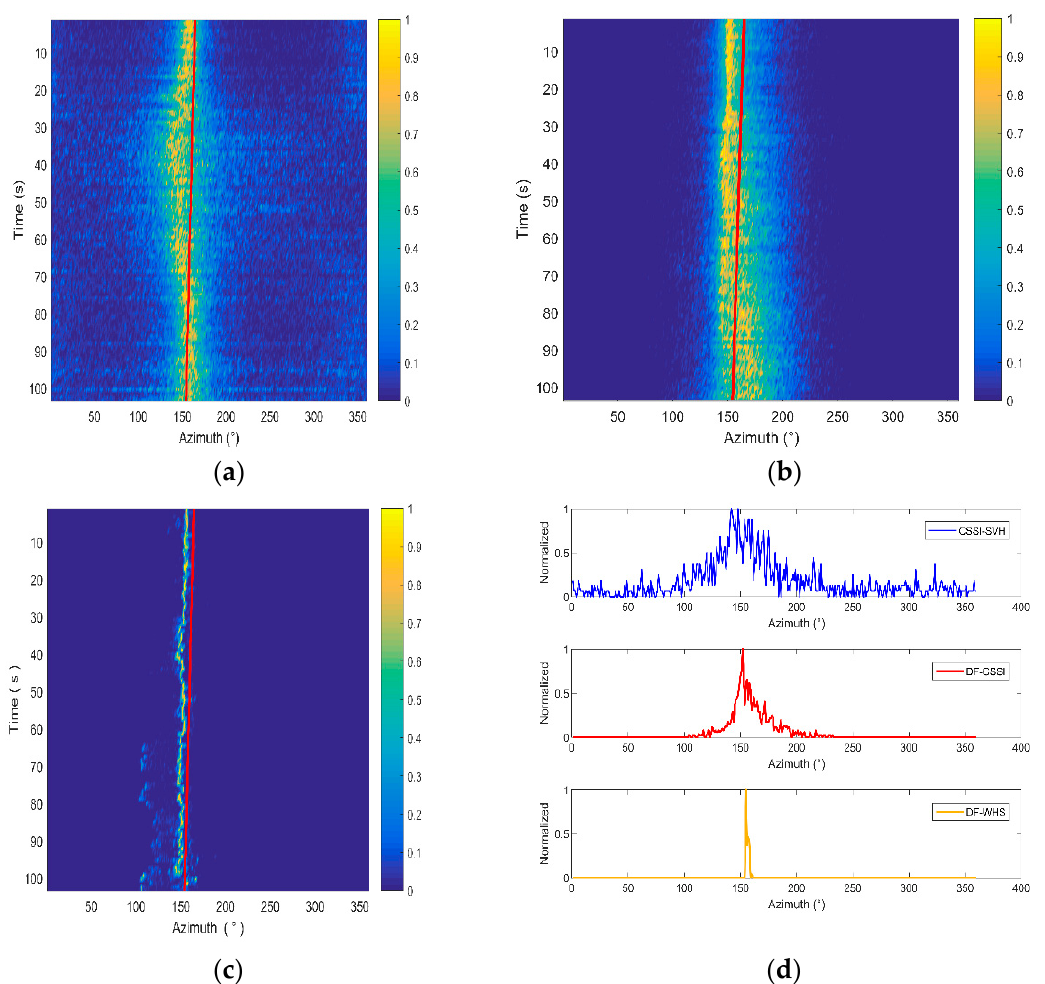
Figure 14. Results of processing frequency band of 200–900 Hz. ( a ) Cross-spectral sound intensity